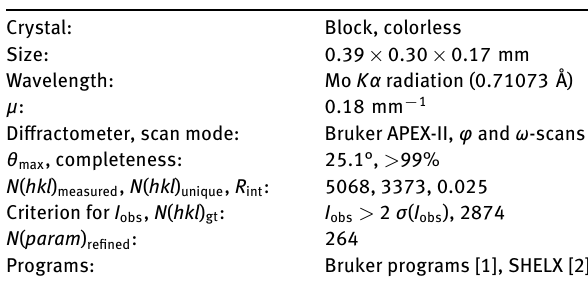
Table 1: Data collection and